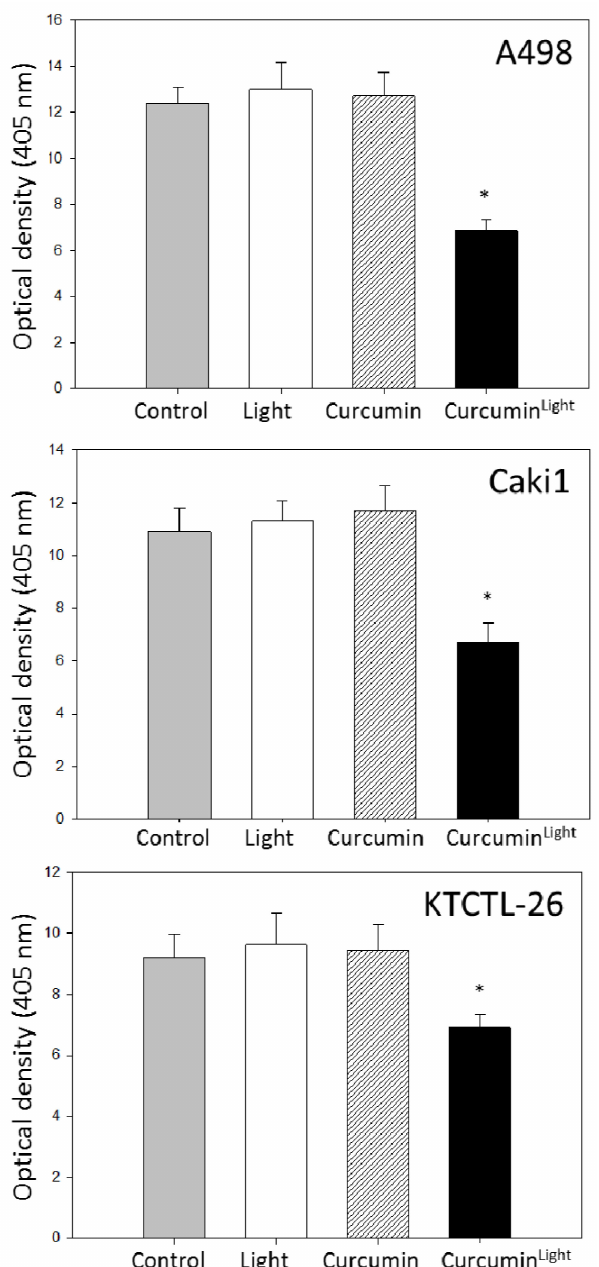
Figure 7. Histone deacetylation activity in A498, Caki1, and KTCTL-26 cell lines. Controls remained untreated (grey) after irradiation (white) or incubation with 0.2 µ g/mL curcumin without (hatched) or with irradiation (black). Each experiment was done in triplicate and repeated five times. Data from one representative experiment are shown. * Indicates significant difference to